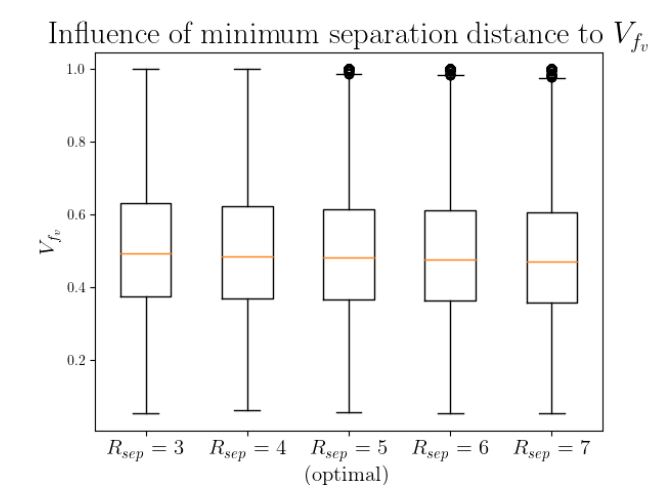
Figure 19. Minimum separation distances in relation to V f